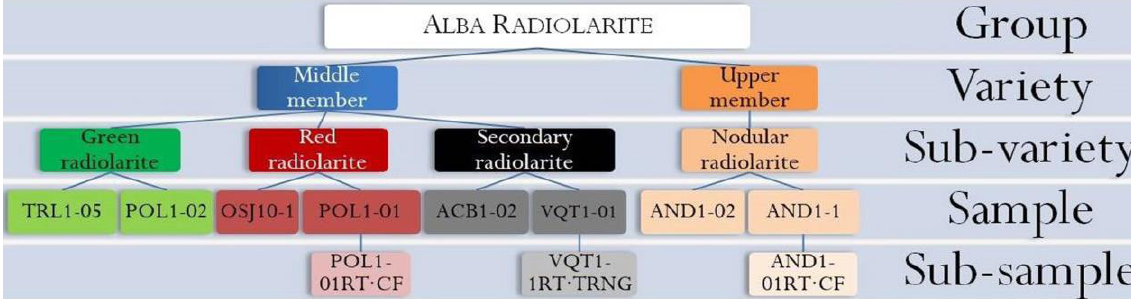
Figure 4: Example of the hierarchical organisation of the